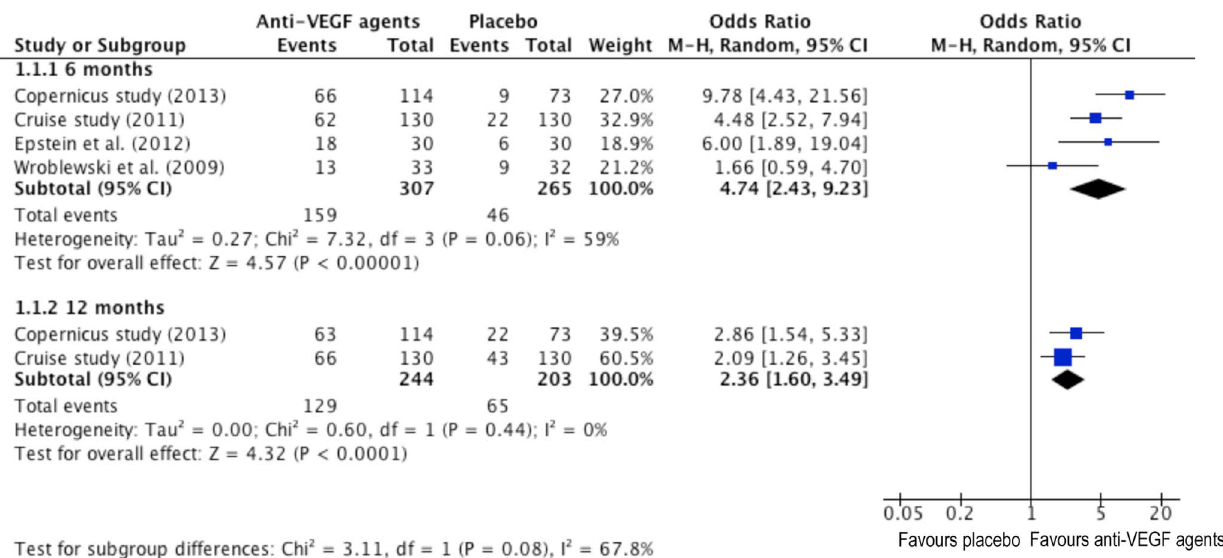
Figure 2. Forrest plots for the proportion of patients with an improvement from baseline in best-corrected visual acuity (BCVA) of greater than or equal to 15 letters on Early Treatment in Diabetic Retinopathy Study (ETDRS) Chart at six and twelve months between anti-VEGF and placebo group.